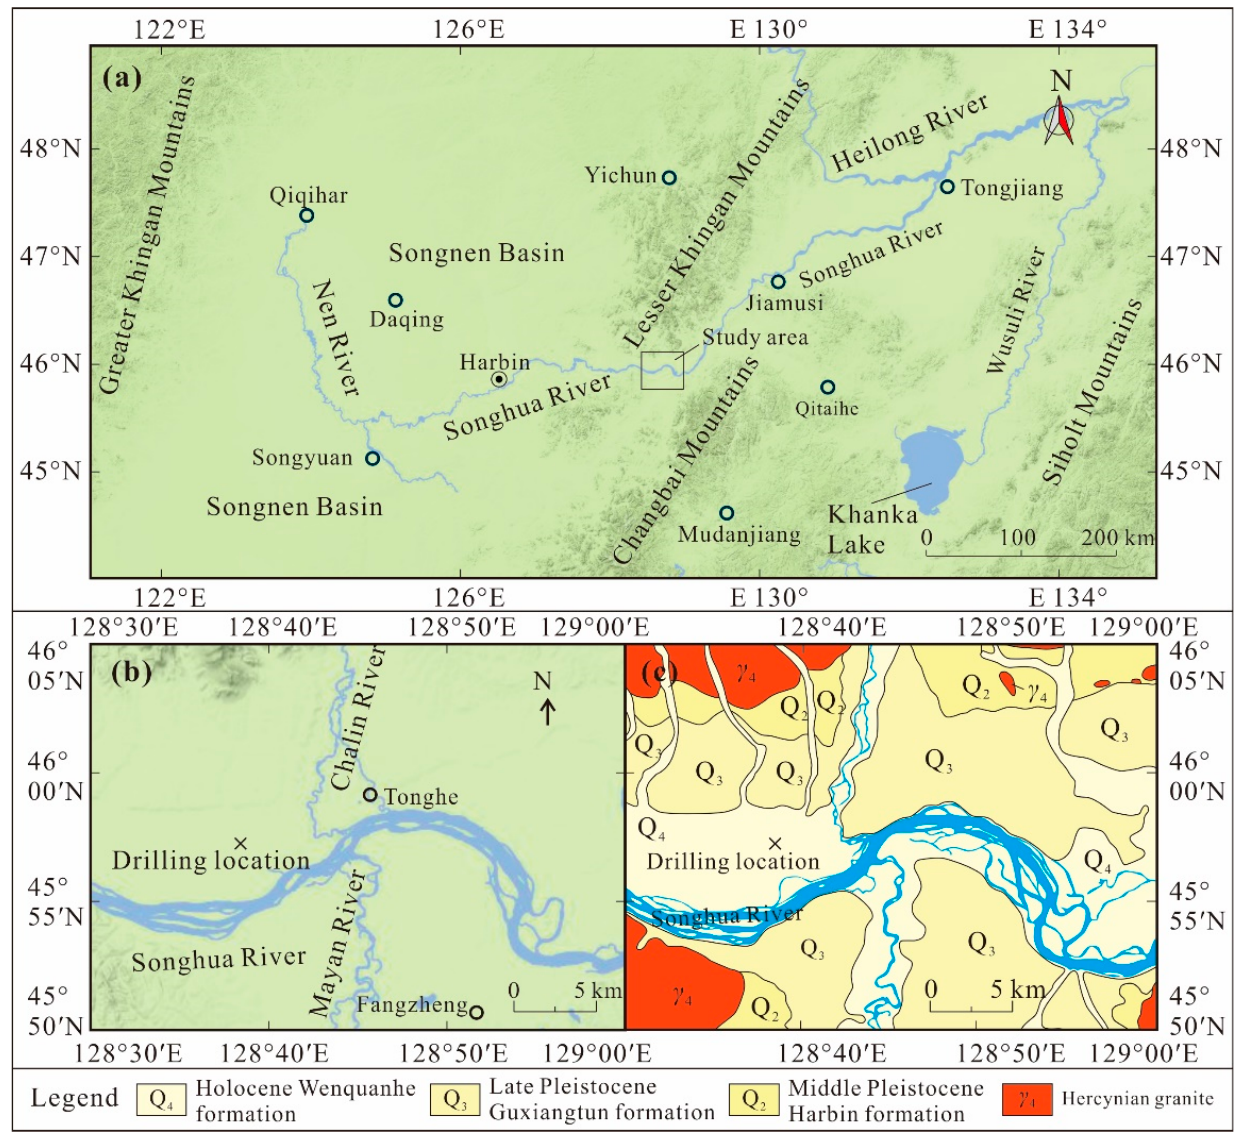
Figure 1. ( a ) Satellite map of Songhua River drainage; ( b ) satellite map of Tonghe area; ( c ) geology map of Tonghe area cited from BGMRHP [25].